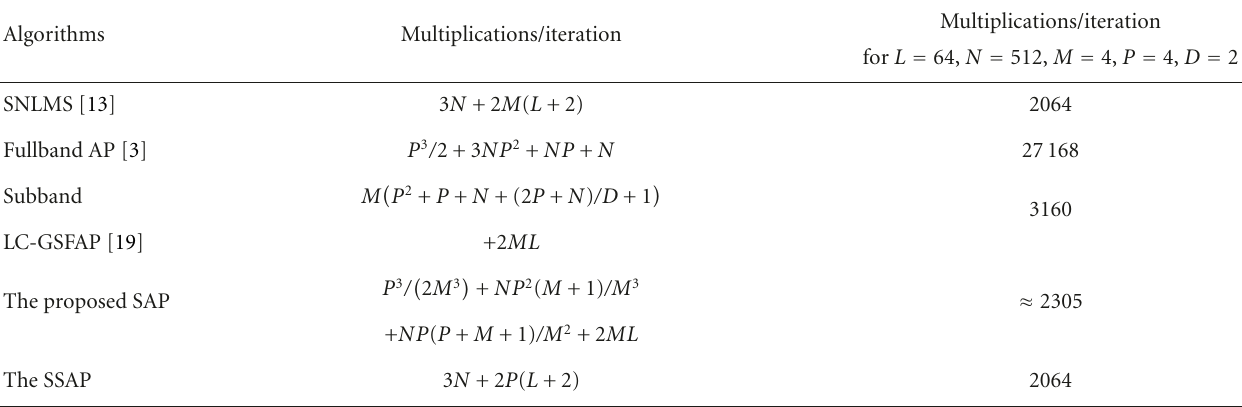
Table 1: Comparison of the computational complexities; N is the length of adaptive filter or unknown system (filter), L is the length of analysis and synthesis filters, M is the number of subbands, P is the projection order, and D is the size of data frame in LC-GSFAP.